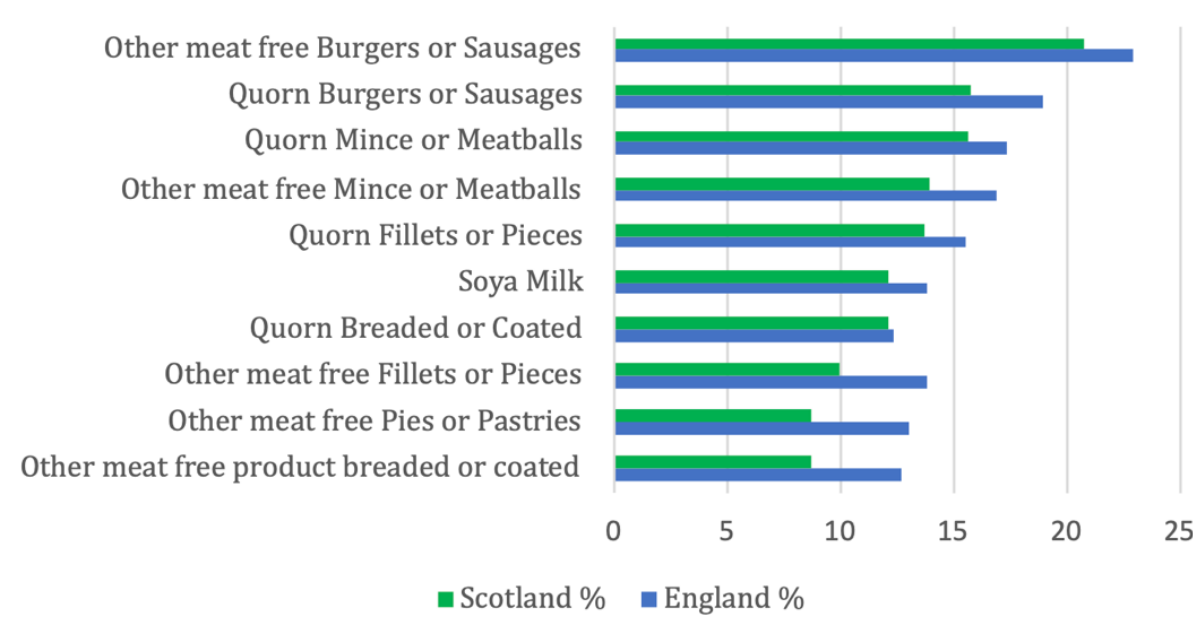
Figure 1. Ten most frequently purchased plant-based alternative food items.